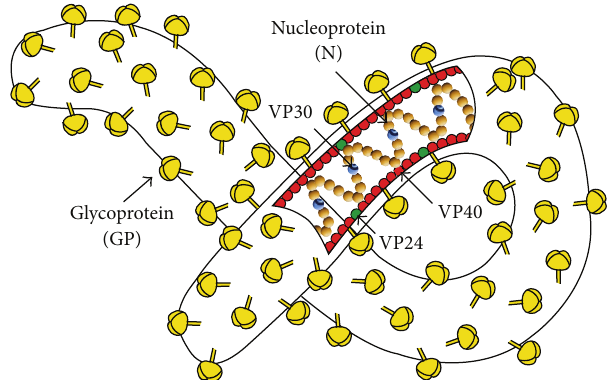
Figure 1: Ebola virus representation. The virion and main proteins are represented. The see-through window in virion shows the negative- sense RNA single-stranded genome covered by nucleoproteins and